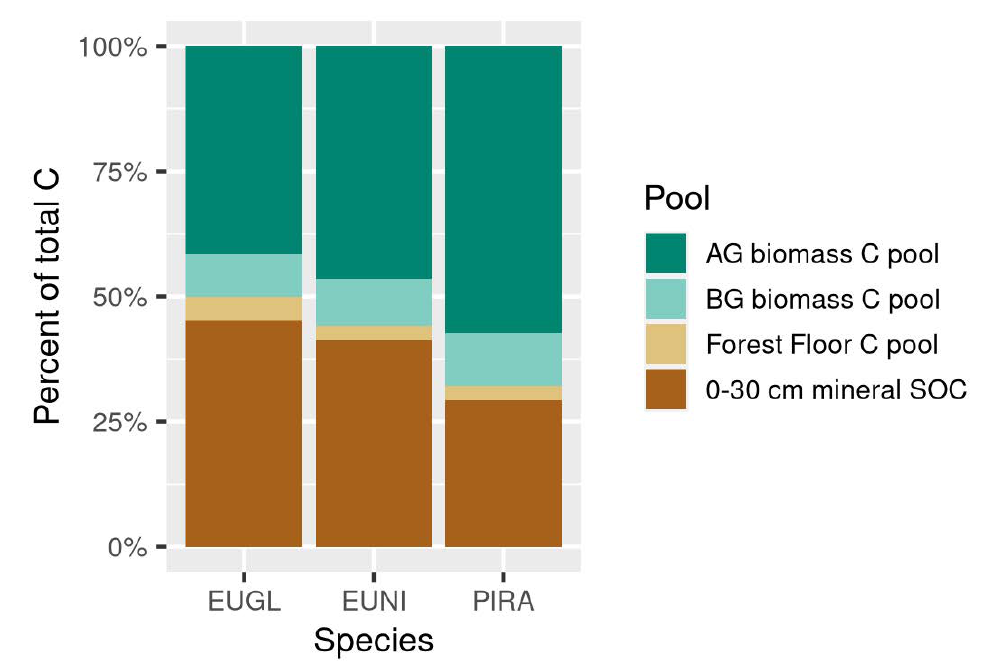
Figure 5. Proportion of C in the four pools evaluated (Above-ground (AG) biomass, Below-ground (BG) biomass, forest floor and 0–30 mineral soil organic carbon (SOC) C pools) for Eucalyptus globulus (EUGL), Eucalyptus nitens (EUNI) and Pinus radiata (PIRA) at rotation age (10–14 years-old for EUGL and EUNI, 20–24 years-old for